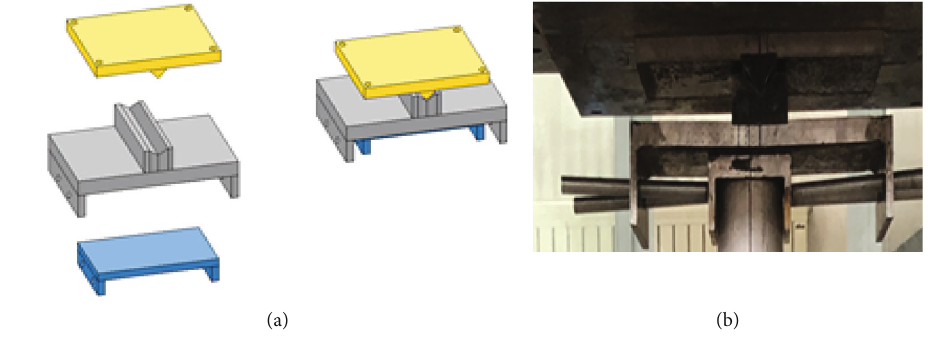
Figure 1: (a) Hinge support. (b) Hinge support.